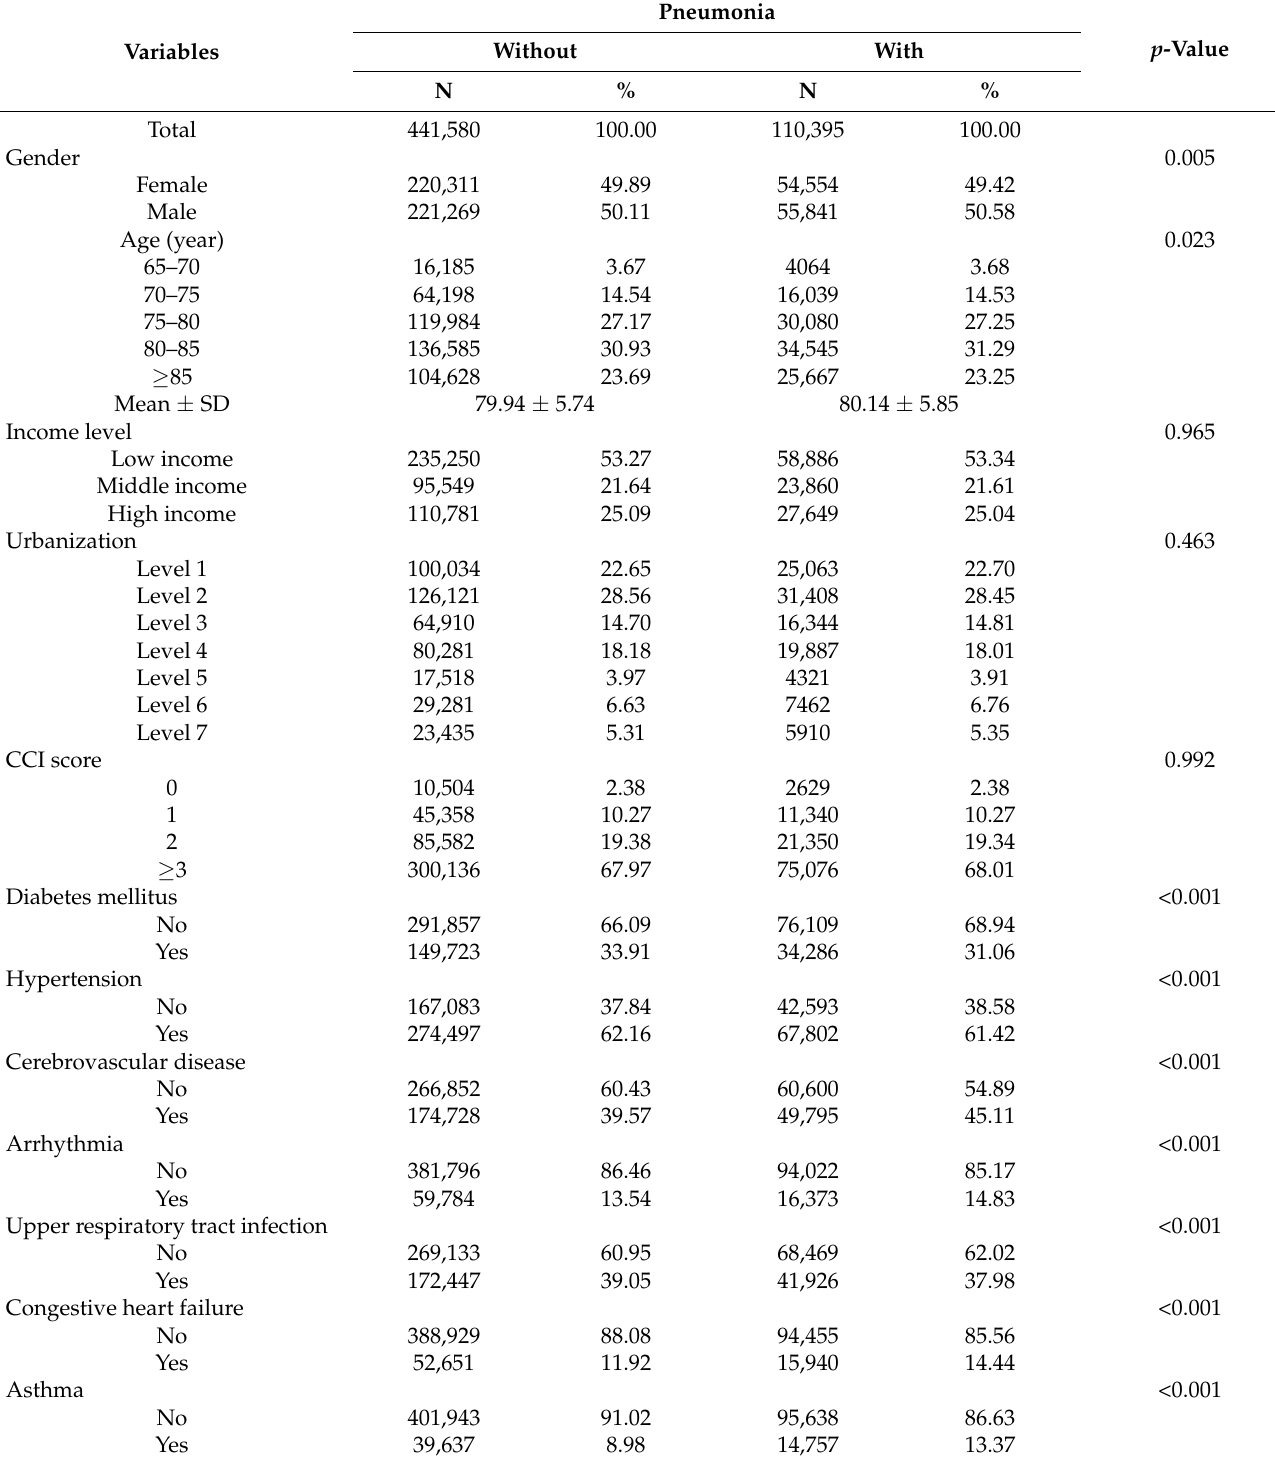
Table 1. Baseline characteristics of older adult patients with Parkinson’s